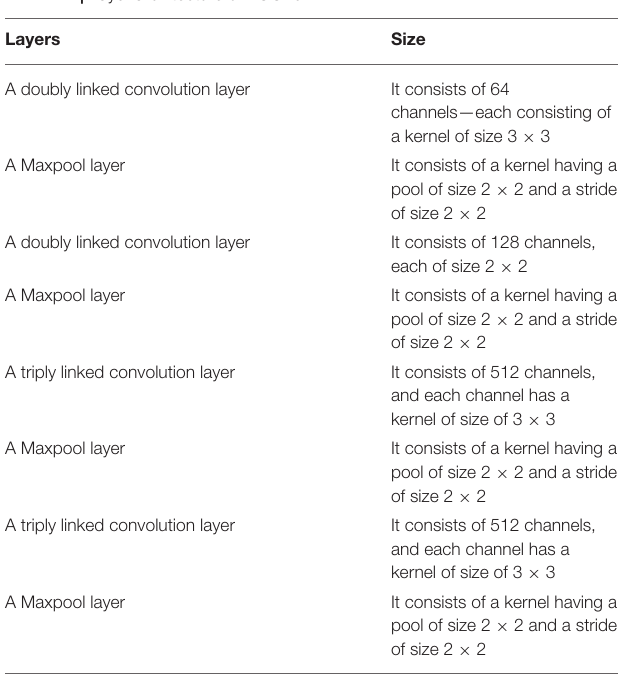
TABLE 2 | Layer architecture of VGG16.